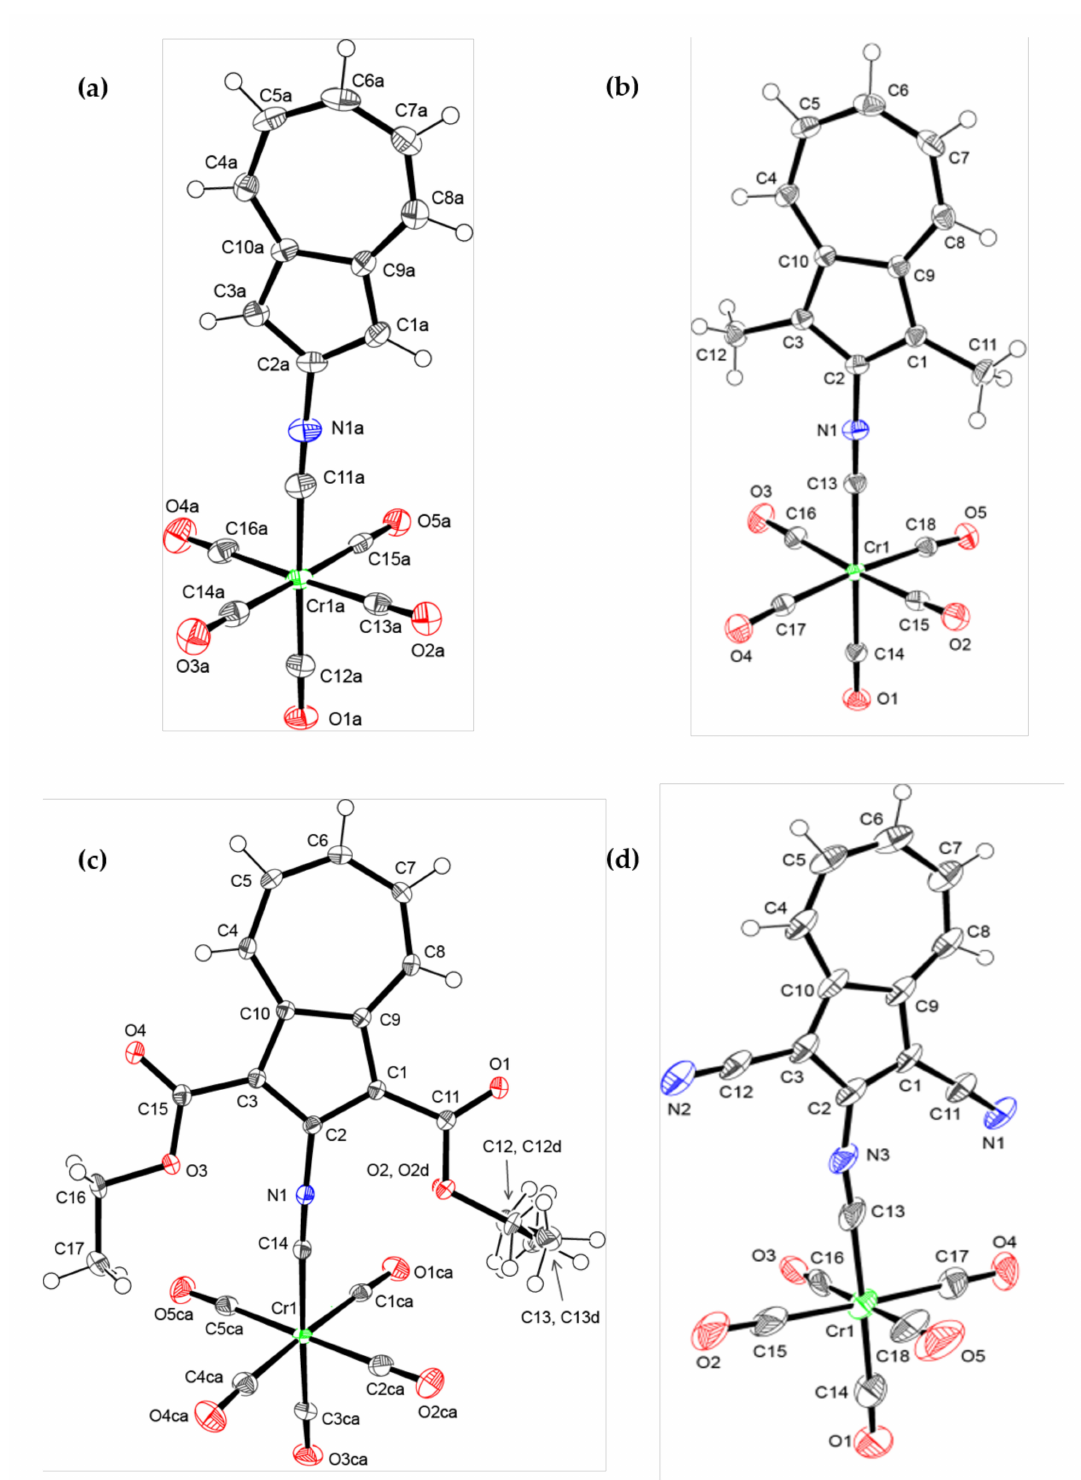
Figure 5. ( a ) One of two crystallographically independent molecules in the solid-state structure of 6 (the other molecule is shown in Figure S5); ( b ) the solid-state structure of 7 ; ( c ) the solid-state structure of 8 (one ethoxy group shows a minor disorder over two positions; also see Figure S6); ( d ) the solid-state structure of 10 . All thermal ellipsoids are drawn at the 50% probability